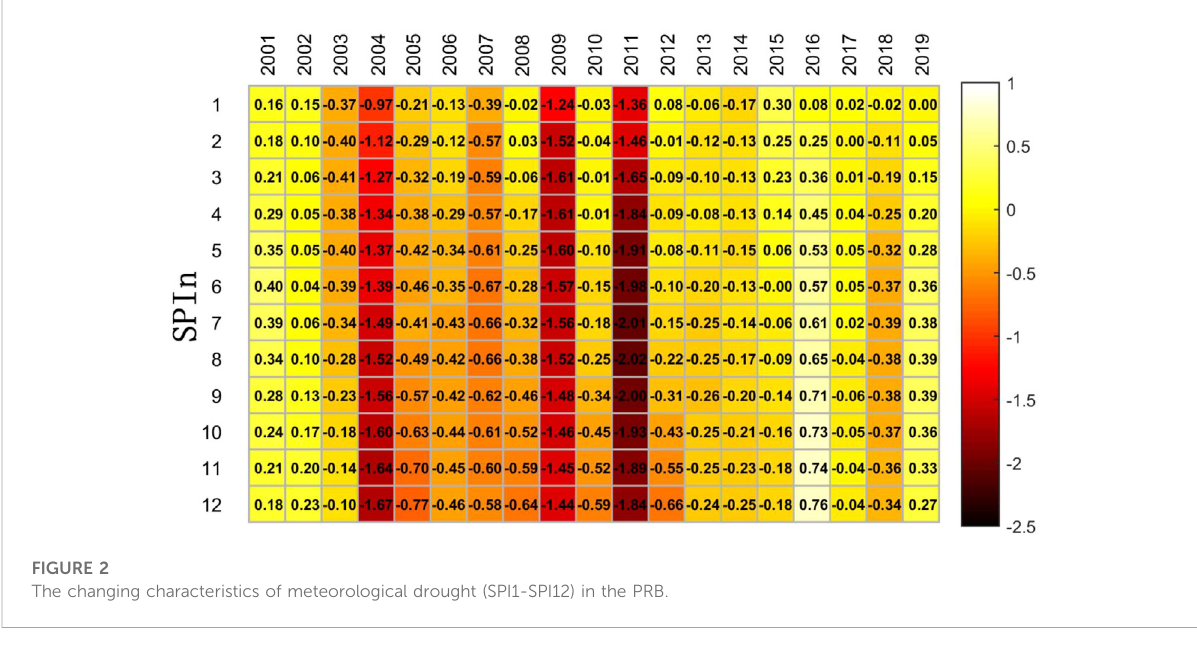
FIGURE 2 The changing characteristics of meteorological drought (SPI1-SPI12) in the PRB.